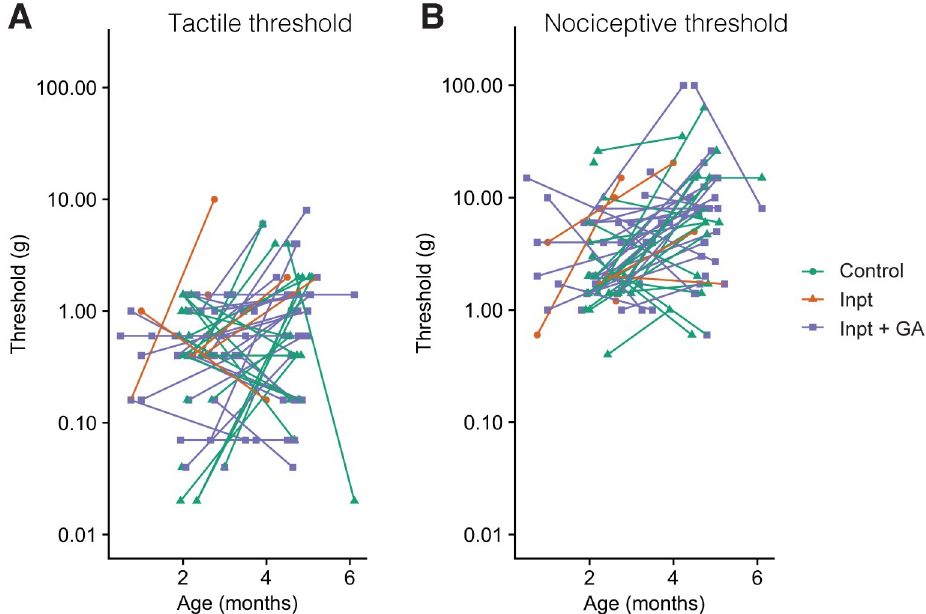
Fig 6. Sensory thresholds measured from single and multiple study visits during infancy. Lines indicate data taken from same subject. Colours indicate cohort. Abbreviations: g = grams; GA = general anaesthesia exposure; TT = tactile threshold; NT = nociceptive threshold. Definitions: Tactile threshold = average lowest stimulus intensity required to generate any visible motion of the ankle, knee or hip; Nociceptive threshold = average stimulus intensity required to evoke brisk leg withdrawal away from the stimulus, consisting of knee- or